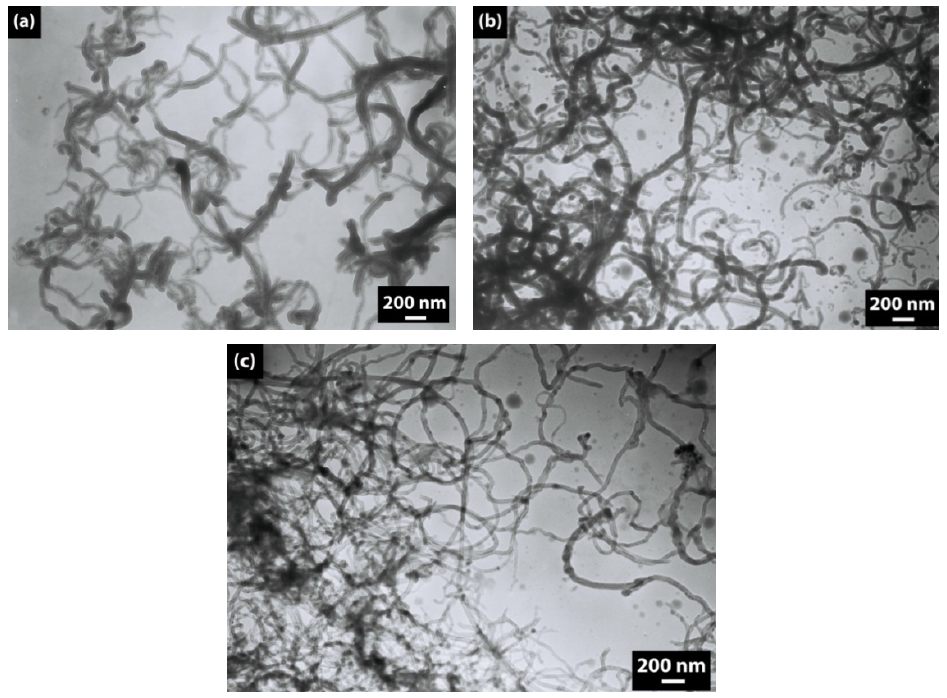
Figure 2. TEM micrographs of ( a ) CNT–DBSA, ( b ) CNT–CTAB, and ( c )